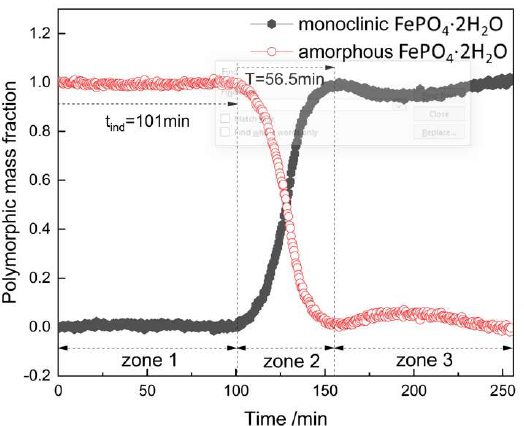
Figure 12. The standard curve of monoclinic FePO 4 ·2H 2 O.